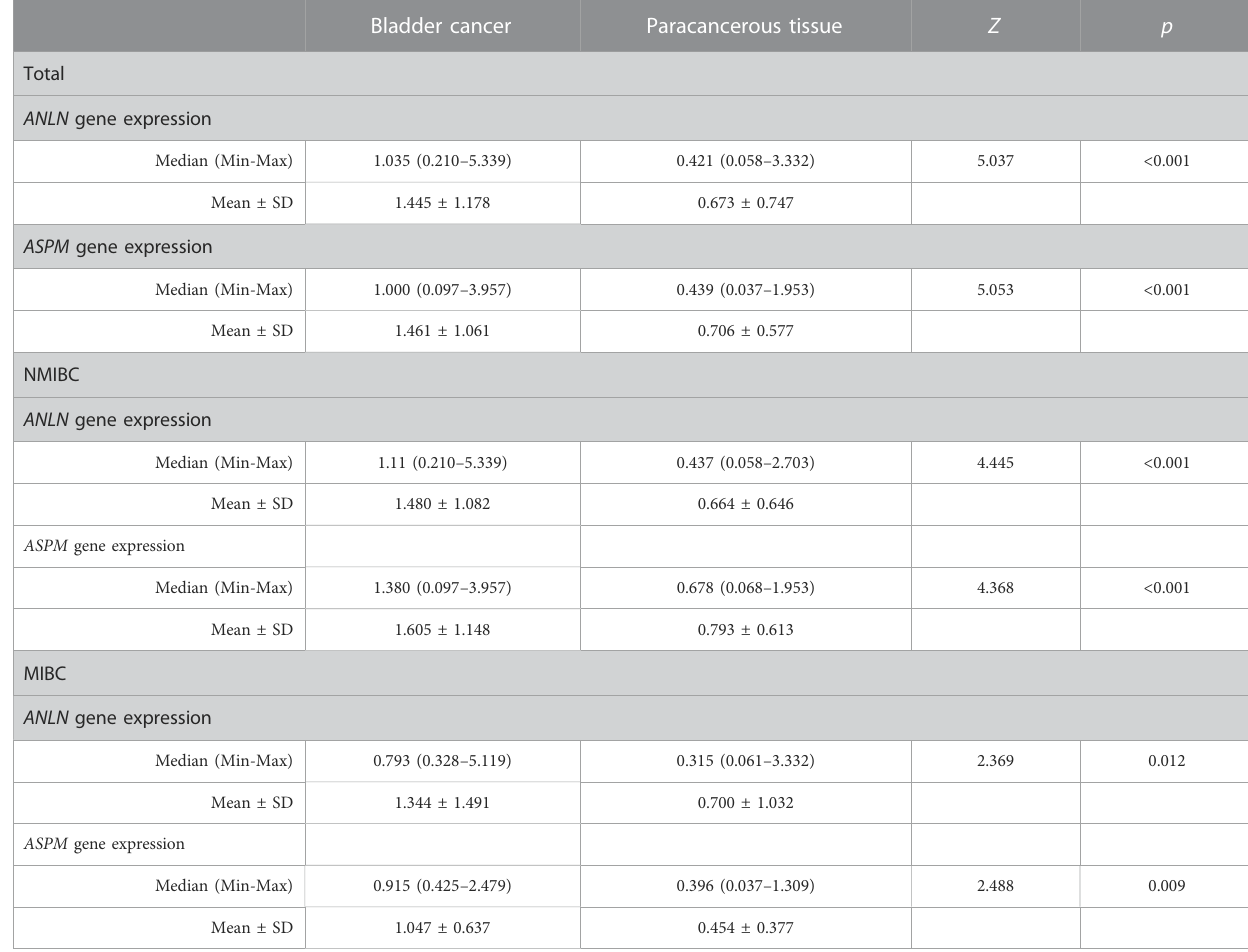
TABLE 4 Comparison between bladder cancer tissues and paracancerous tissues according to the expression levels of ANLN and ASPM genes in total samples ( N = 35), NMIBC ( N = 26) and MIBC ( N =